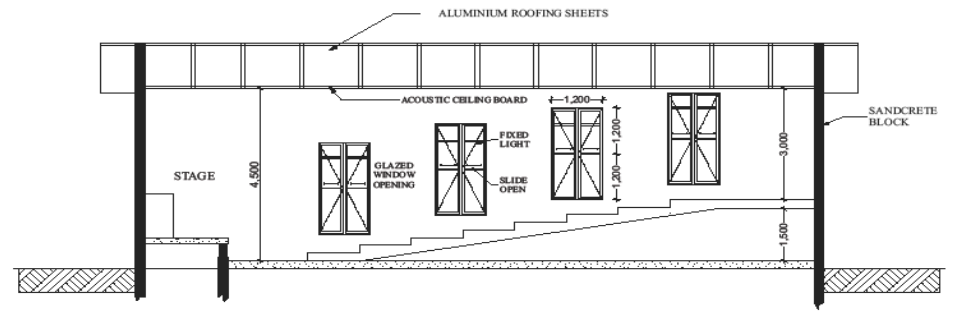
Figure 2. Cross ‐ section of the lecture theatre.